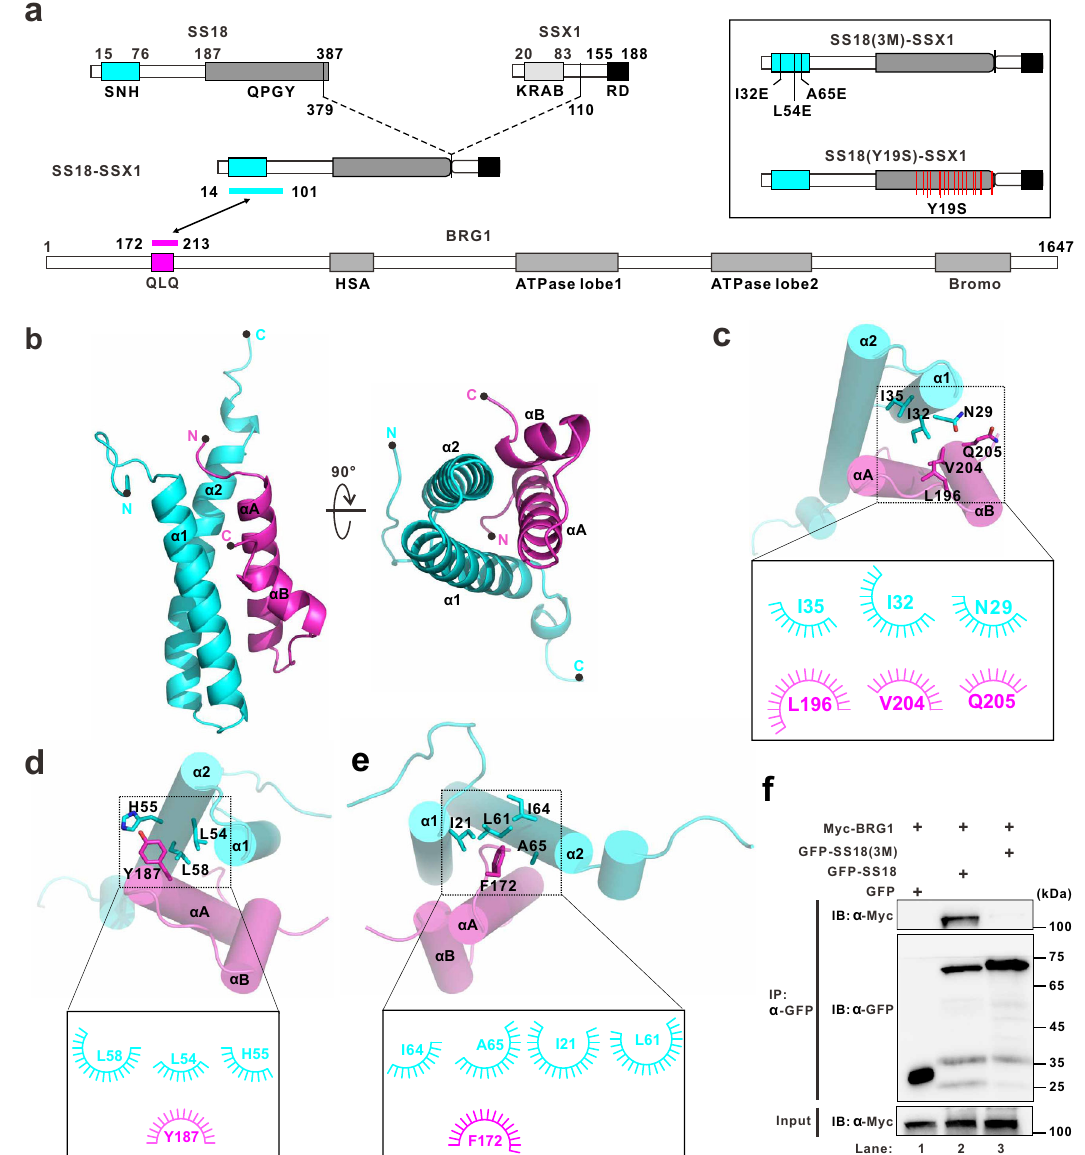
Fig. 1 Crystal structure of the complex BRG1 and SS18 or SS18-SSX1. a Schematic representation of full-length SS18, SSX1, SS18-SSX1, and BRG1. The oncoprotein SS18-SSX1 encompasses 457 amino acids and preserves the amino-terminal 379 amino acids of SS18 as well as the carboxy-terminal 78 amino acids of SSX1. The protein fragments of the SS18 (14 – 101) /BRG1 (172 – 213) complex used for structural determination are indicated by a two-way arrow, and colored cyan and magenta, respectively. The schematic diagram in the insert indicates the mutant SS18(3M)-SSX1, which contained three amino acids I32, L54, and A65 mutated to glutamic acid in the SNH domain, and the mutant SS18(Y19S)-SSX1, which contained 19 tyrosine residues mutated to serine in the QPGY domain. b Cartoon representation of the SS18 (14-101) (cyan)/BRG1 (172-213) (magenta) complex viewed from the side and bottom. The N- and C-termini of the two proteins are labeled. PDB entry code: 7VRB. c – e Ligplot diagrams in the black frame indicate hydrophobic interactions between SS18 and BRG1. Three groups of hydrophobic cores are shown as spoked arcs, respectively in ( c – e ). f Co-IP experiments testing the interaction between SS18 wild-type (WT) or the mutant SS18(3M) and BRG1. The mutant SS18(3M) contains three amino acid mutations I32E, L54E, and A65E. Extracts were prepared from HEK293T cells transfected with combinations of plasmids, as indicated. The bottom panel shows 3% of the Myc-Brg1 as input for each